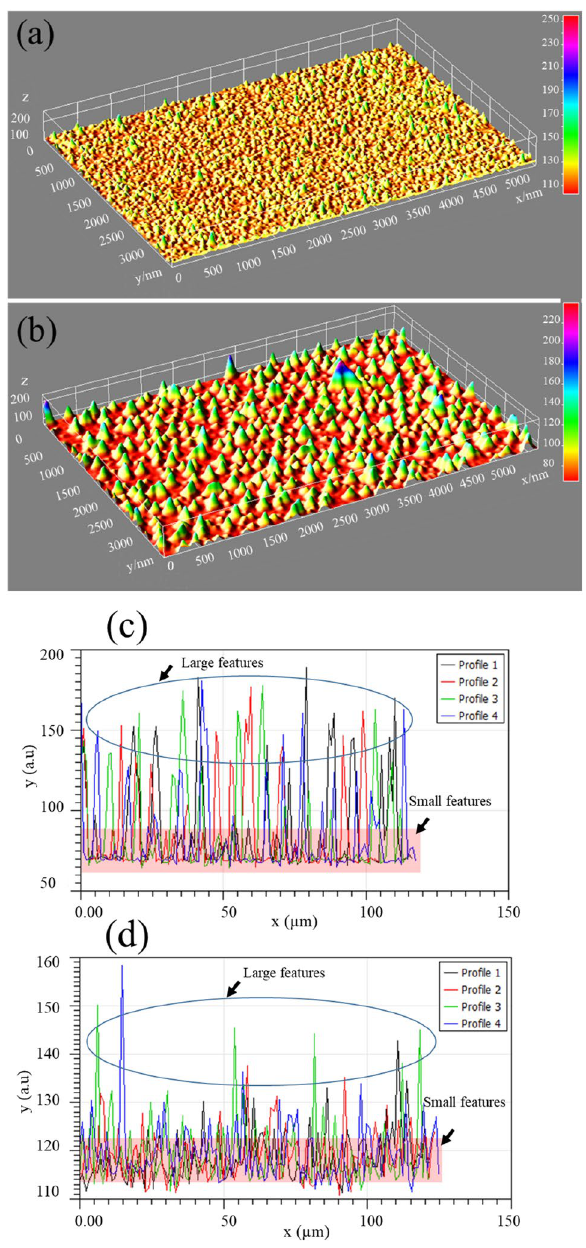
Figure 7. Interactive 3D-surface plots constructed for images shown in ( a ) and ( b ) of Fig. 3 and the surface line profiles, drawn over different regions ( c , d ). The luminance of the image is interpreted as height for the plot and is indicated by the colour scale bars to make an estimation of the particle dimension. The highlighted regions and the circles indicate the smaller and larger features of the particulate surfaces formed by the discharge